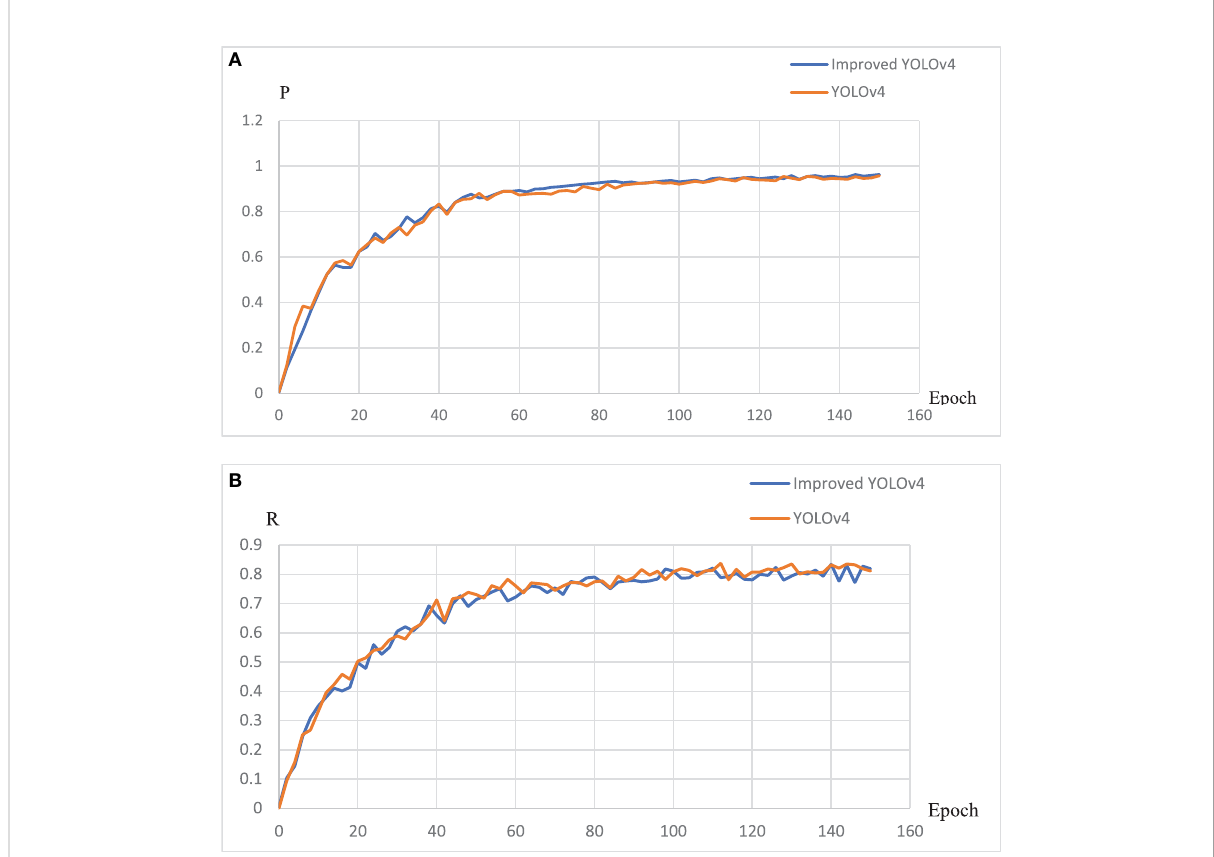
FIGURE 8 The changes of the P and R indicators during the training process: (A) P curve; (B) R